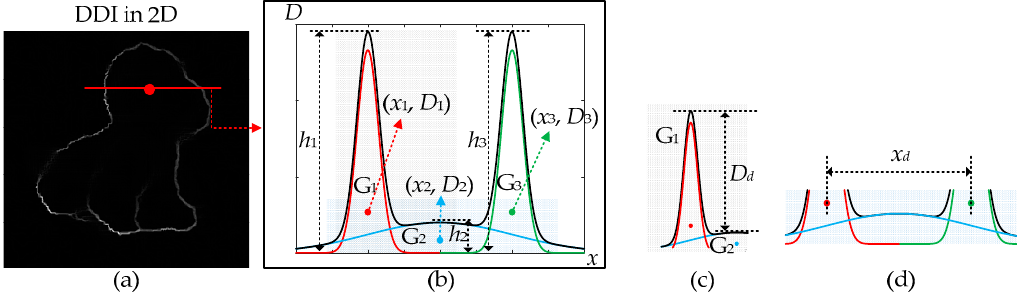
Figure 6. Evaluation model composed of three Gaussian models: examples of ( a ) the DDI, ( b ) the DDI profile along the grasp candidate, ( c ) the height difference D d , and ( d ) the width x d . The proportion p is defined as the ratio of G 1 to G 3 .